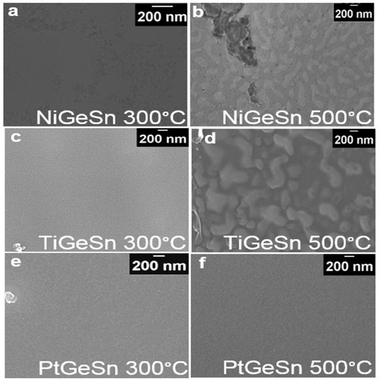
Representative SEM images showing the continuity, or lack of, for the stanogermanides formed in this work; the left-hand column is related to the annealing at 300 °C: a) NiGeSn; c) TiGeSn; e) PtGeSn while the right-hand column refers to the annealing at 500 °C: b) NiGeSn; d) TiGeSn; f) PtGeSn.